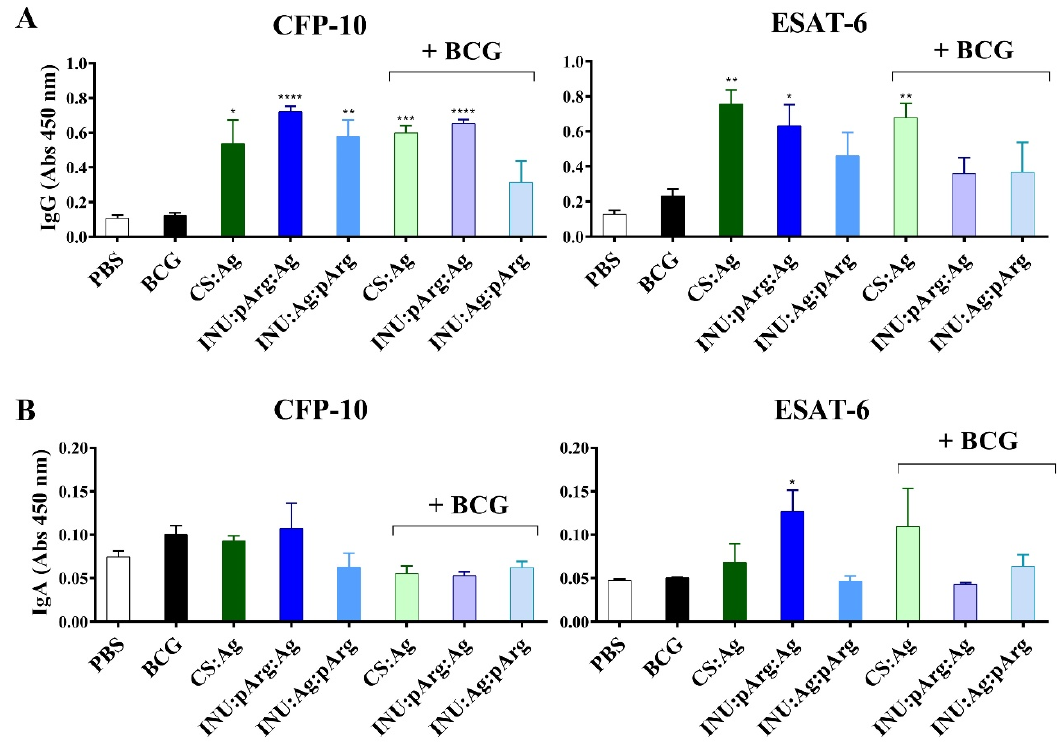
Figure 8. Serum IgG ( A ) and IgA ( B ) titers against CFP-10 and ESAT-6 measured in sera and BAL diluted 1 / 10 and 1 / 3, respectively, after three intranasal immunizations with the CS:Ag, INU:pArg:Ag, and INU:Ag:pArg nanocapsules in naïve mice or in mice previously immunized subcutaneously with the BCG vaccine ( + BCG). Mice treated with PBS (PBS) or only immunized with BCG (BCG) were used as control groups. Ag: Antigen, BAL: bronchoalveolar lavage fluid, CS: Chitosan, Immunoglobulin (Ig), INU: Inulin, pArg: Polyarginine. Statistical significance: * P ≤ 0.05, ** P ≤ 0.01, *** P ≤ 0.001, **** P ≤ 0.0001.